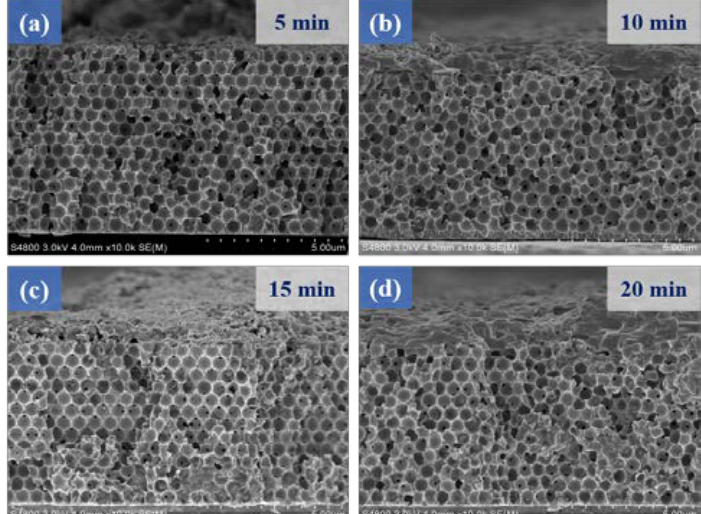
Figure 5. Cross-sectional SEM images of the MoS 2 /Ni-IOS microelectrode samples fabricated with different electrodeposition times, with a − 10 mA/cm 2 electrodeposition parameter, and the deposition times were ( a ) 5 min, ( b ) 10 min, ( c ) 15 min, ( d ) 20 min.